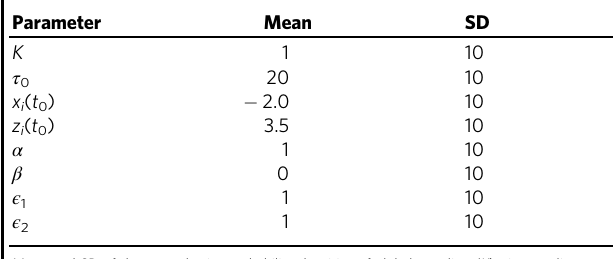
Mean and SD of the normal prior probability densities of global coupling ( K ), time scaling parameter ( τ 0 ), initial conditions ( x i ( t 0 ), z i ( t 0 )), amplitude scaling ( α ) and offset ( β ) of SEEG log power, observation noise strength in SEEG log power ( ϵ 1 ), and total sensor power ( ϵ 2 ). For parameters that are de fi ned only in the probability, densities are truncated below at